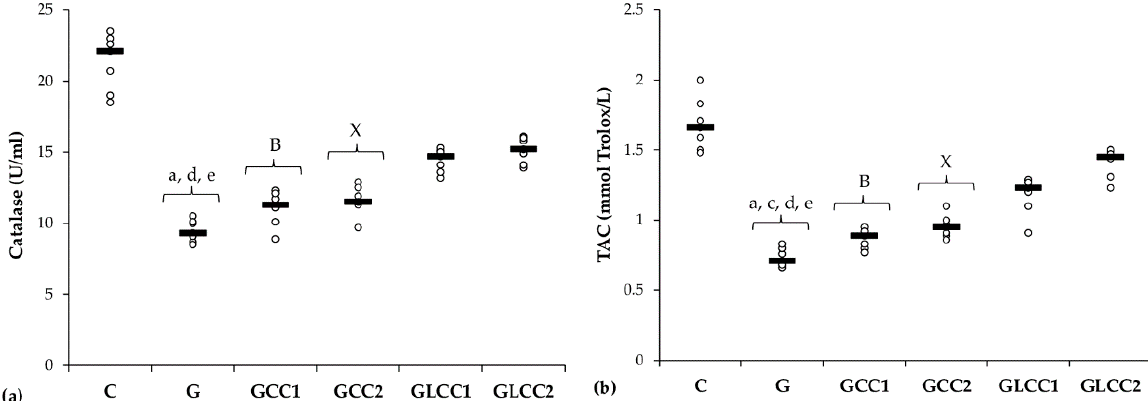
Figure 3. Variation by groups of serum antioxidant capacity: ( a ) Catalase and ( b ) TAC (total antioxidant capacity) by groups. Notes: The circles represent the individual values, and the horizontal line is given by the median. Abbreviations: C, Control; G, Gentamicin; GCC1, Gentamicin and CC1 solution; GCC2, Gentamicin and CC2 solution; GLCC1, Gentamicin and LCC1 solution; GLCC2, Gentamicin and LCC2 solution; The letter codes correspond to the p -values < 0.006: a G compared to C; c G compared to GCC2; d G compared to GLCC1; e G compared to GLCC2; B GCC1 compared to GLCC1; X GCC2 compared to GLCC2.